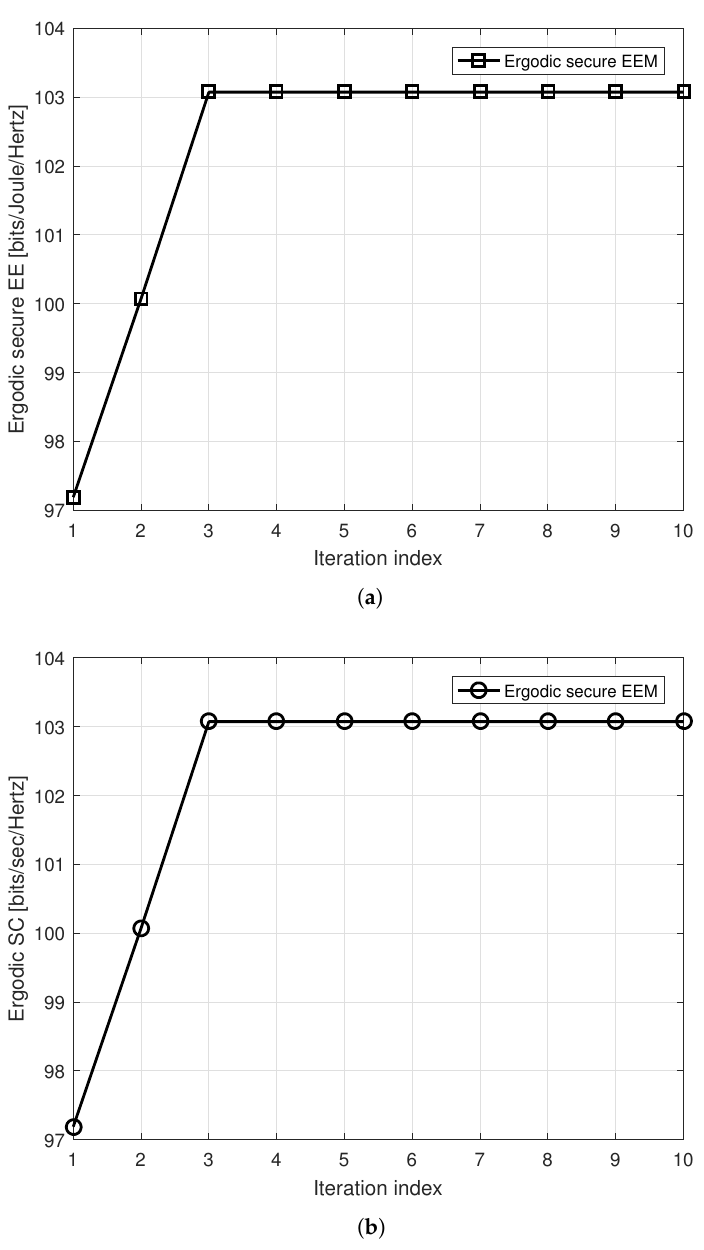
Figure 2. Convergence behavior of iterative algorithms. ( a ) EE versus number of iterations, ( b ) SE versus number of